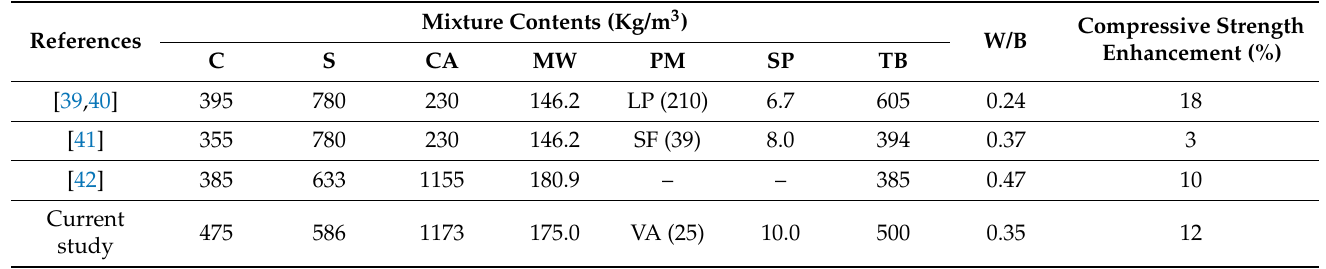
Table 9. Comparison of the effectiveness of MW in current and previous studies.